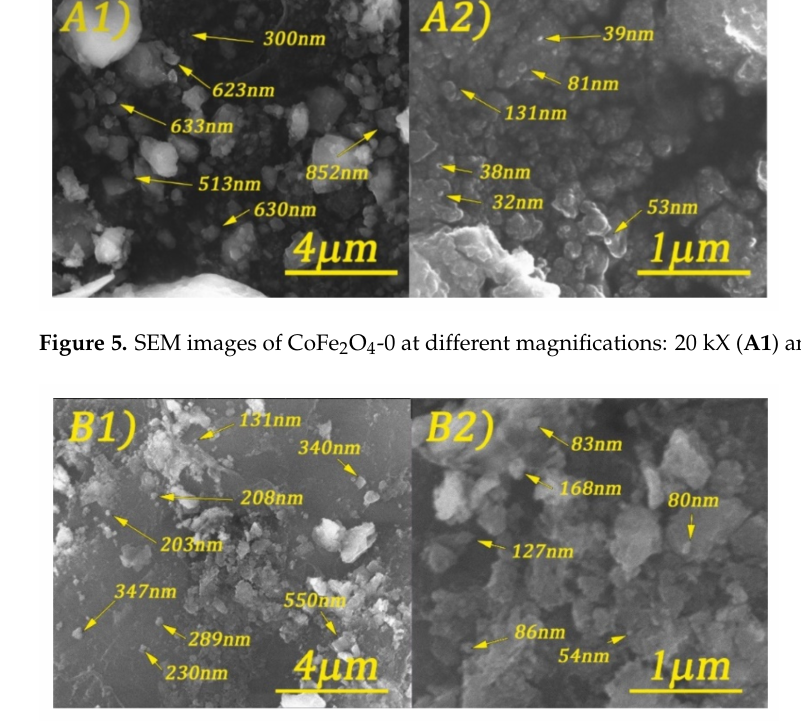
Figure 6. SEM images of CoFe 2 O 4 -0.1 at different magnifications: 20 kX ( B1 ) and 80 kX ( B2